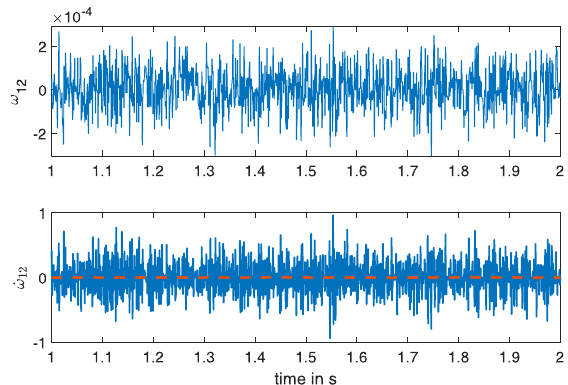
Fig. 13 Plots of a σ and b ˙ σ with and without RED. Red and blue colors represent with RED and ordinary differentiator respectively